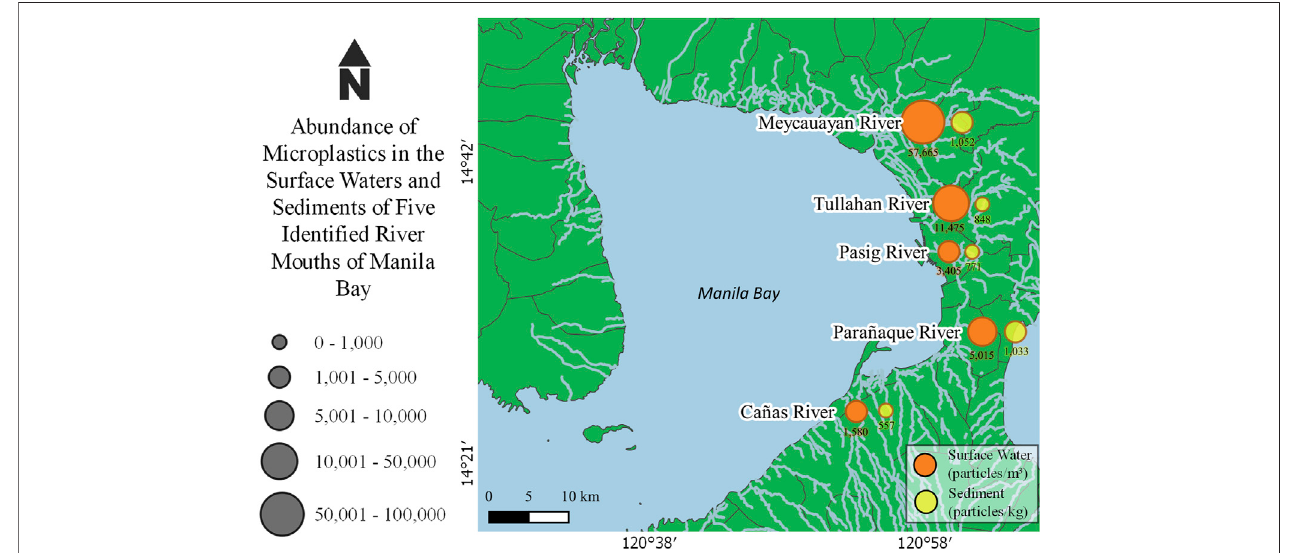
FIGURE 2 | Microplastic abundance in surface waters and sediments of fi ve river mouths in Manila